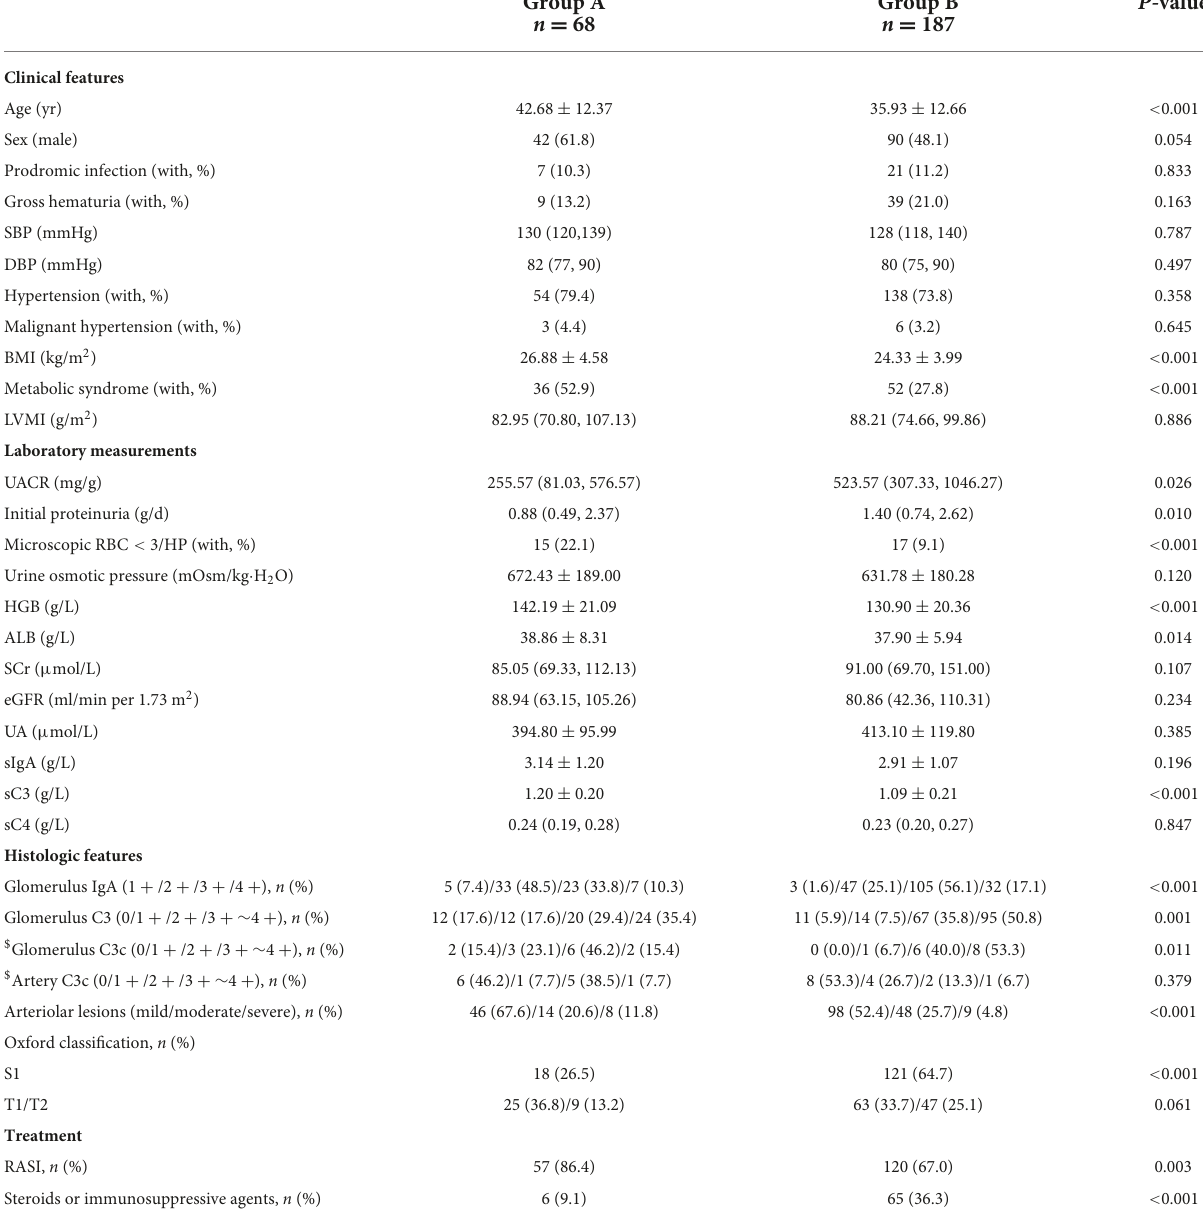
TABLE 4 Demographic, clinical, and histologic characteristics of patients with IgAN with follow-up. ( n = 255).